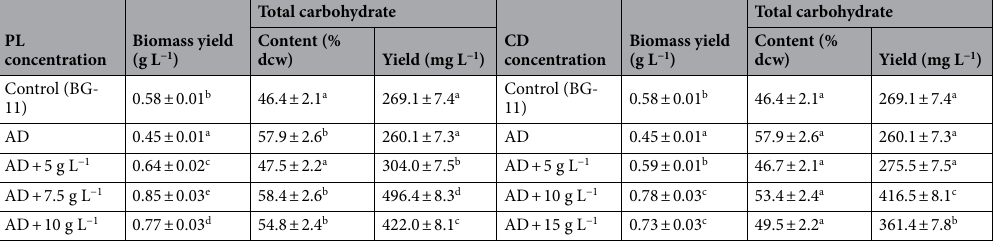
Table 4. Maximum biomass and total carbohydrate production of A. variabilis in AD supplemented with different concentrations of PL and CD, compared to control (BG-11) and un-supplemented AD. Values were calculated as the mean (± SE) of three independent observations, i.e., n = 3. Significant differences among the values (P < 0.05, DMRT) within a column are designated using different alphabetic annotations.